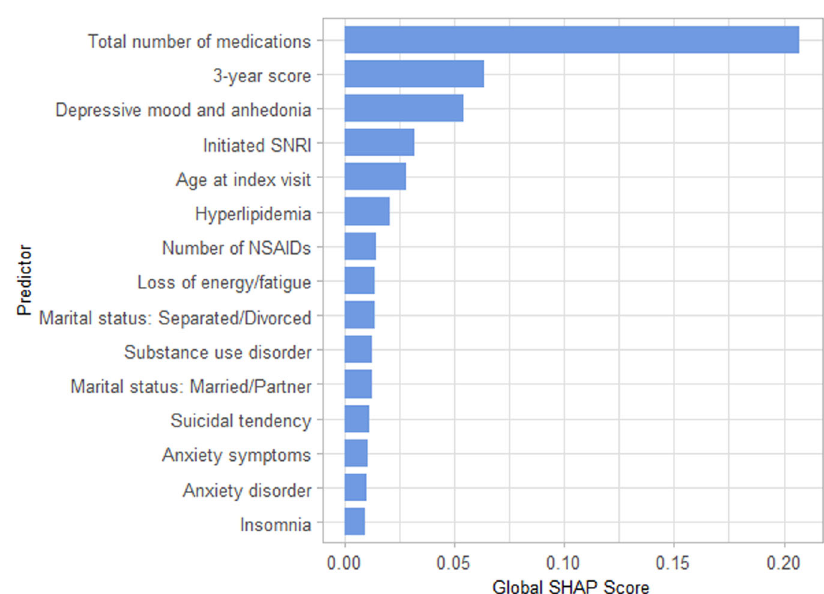
Fig. 2 Top 15 features by global SHAP score. Global SHAP scores were calculated by averaging the absolute values of local (i.e., individual) level SHAP scores, and represent overall contribution of the predictors to the strata. Figure 2 shows the most important predictors overall for Supplementary Table 2 shows performance metrics for the the representative model by global sHapley Additive explanation representative model after patient strati fi cation by age, number of (SHAP) values 46 (i.e., mean of absolute local SHAP values. co-morbidities, counts of depression-related symptoms, and antidepressant class initiated. Performance of the representative Supplementary Fig. 8 shows mean local SHAP values of these model was generally consistent for all model metrics across most important predictors to provide additional information on